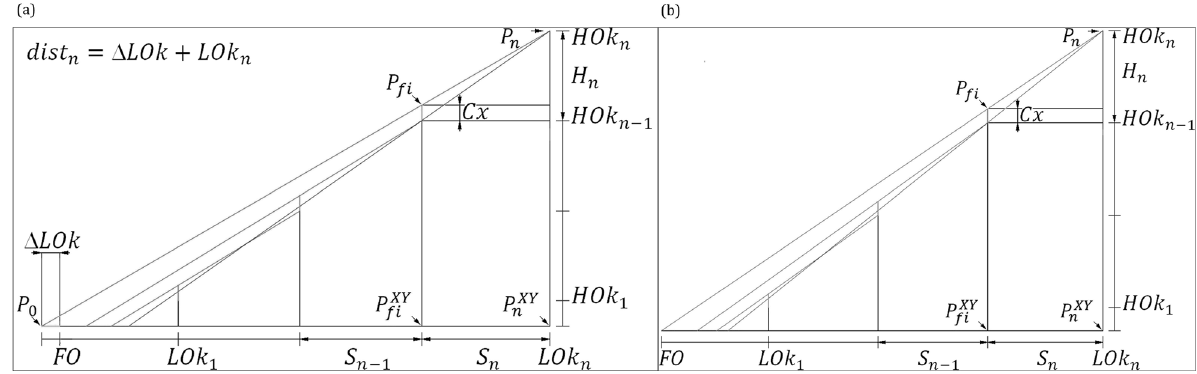
Figure 9: The pro fi le of the stand BBI ( for n 4 = ) in the plane ( containing two points P n , FO , and perpendicular to the OXY plane ) : ( a ) for the approximate value of H n and ( b ) for H n determined by the LSC algorithm.